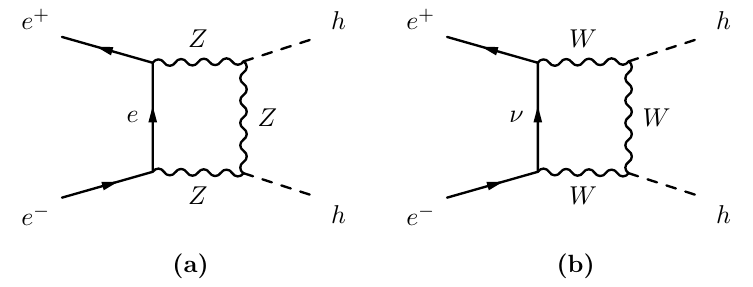
Figure 3. SM 1-loop loop box diagrams for e + e (cid:0) ! hh .